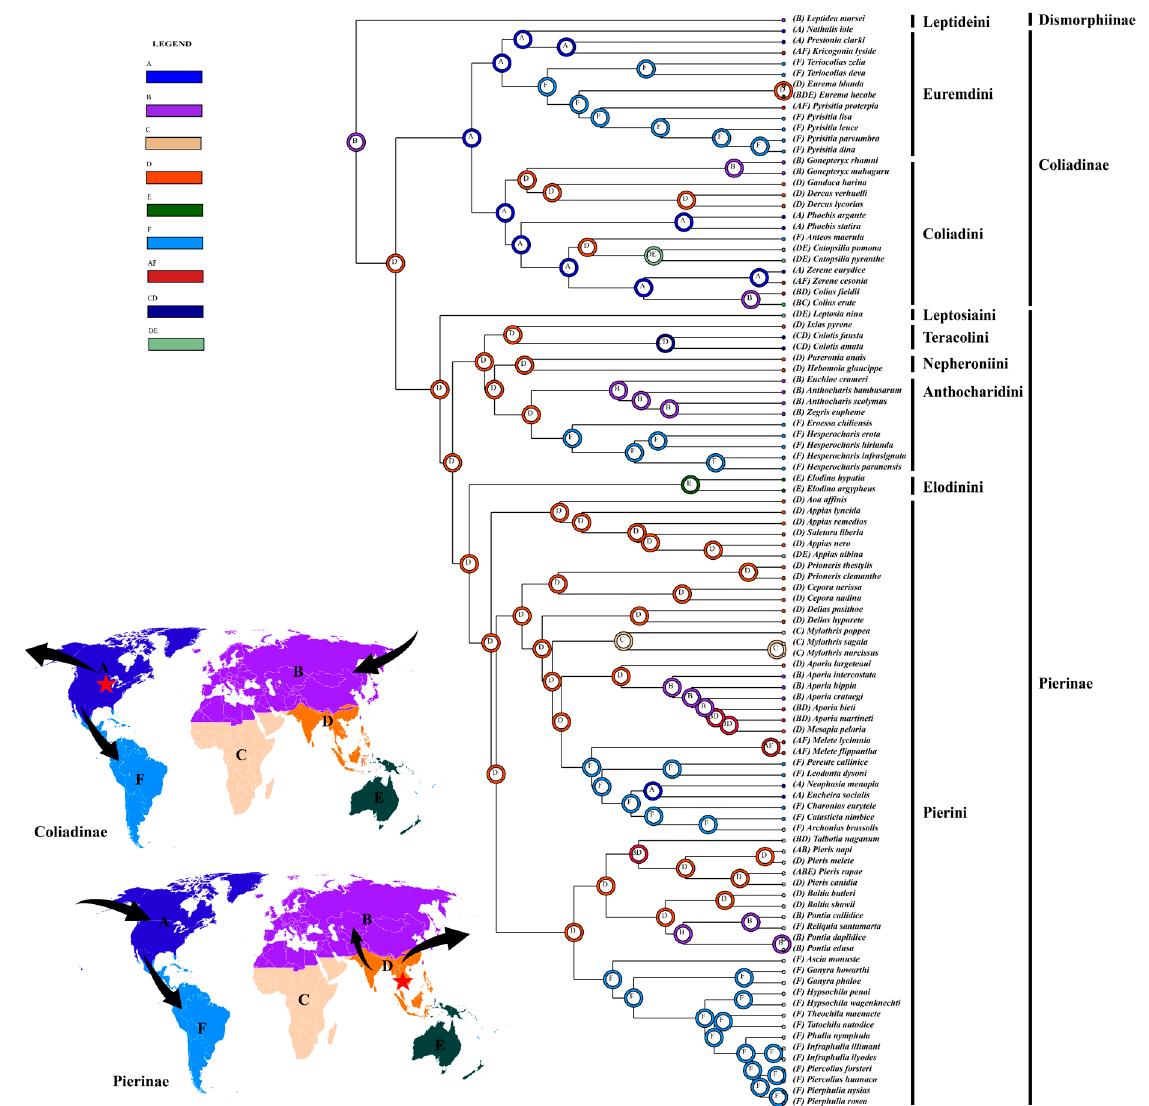
Figure 8. Results of the ancestral area reconstruction of Pieridae from BBM analysis. Biogeographical realms: Nearctic (A), Palearctic (B), Afrotropic (C), Oriental (D), Australasia (E), and Neotropical (F). The originating areas of Coliadinae and Pierinae are indicated by red stars.